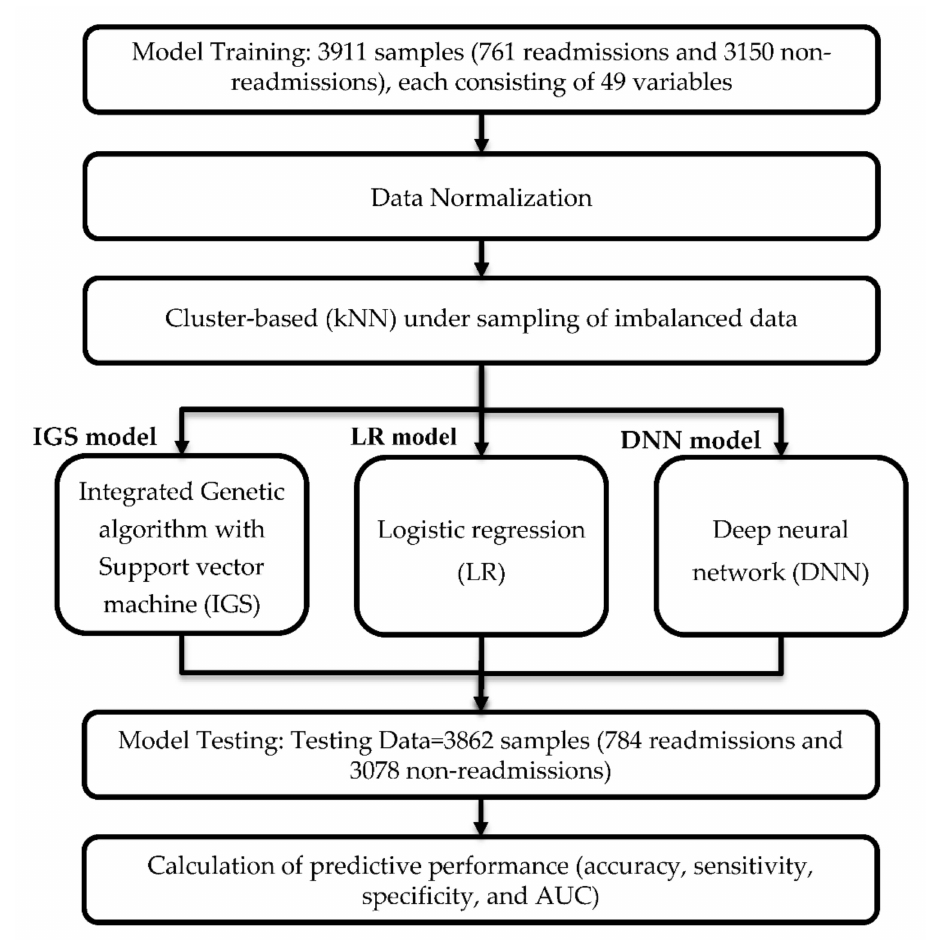
Figure 1. Experimental procedure for designing IGS, DNN, and LR predictive